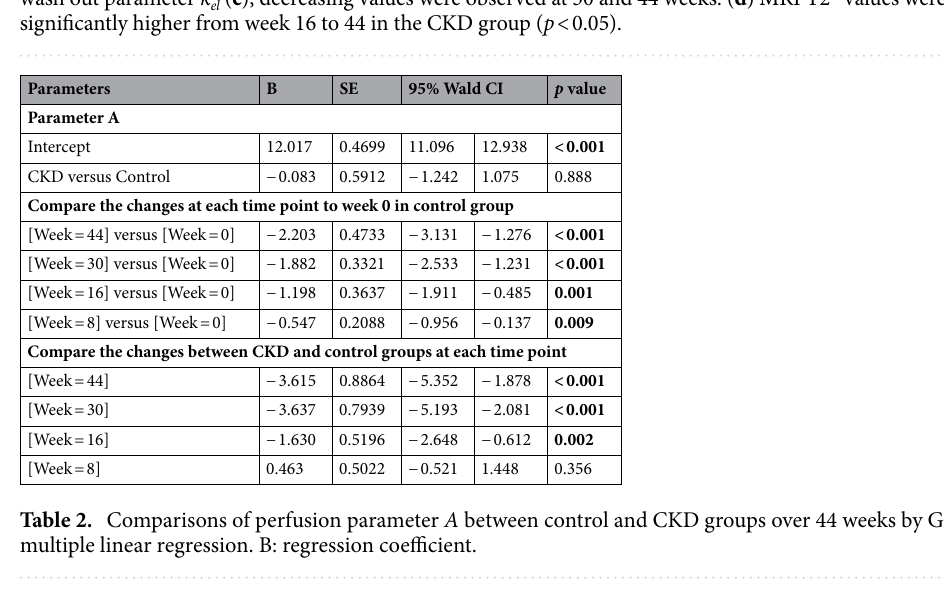
control group, were not significantly different at week 8 ( p values = 0.111) but significantly higher at 16, 30, and 44 weeks ( p values 0.024 to < 0.001). Higher signal intensity is shown in the MRI T2* map presented in Fig. 2c,d. Correlation analysis. The DCE perfusion parameter A and MRI T2* values of infrapatellar fat pad were correlated for the control and CKD groups. The Spearman correlation coefficient between the perfusion param-